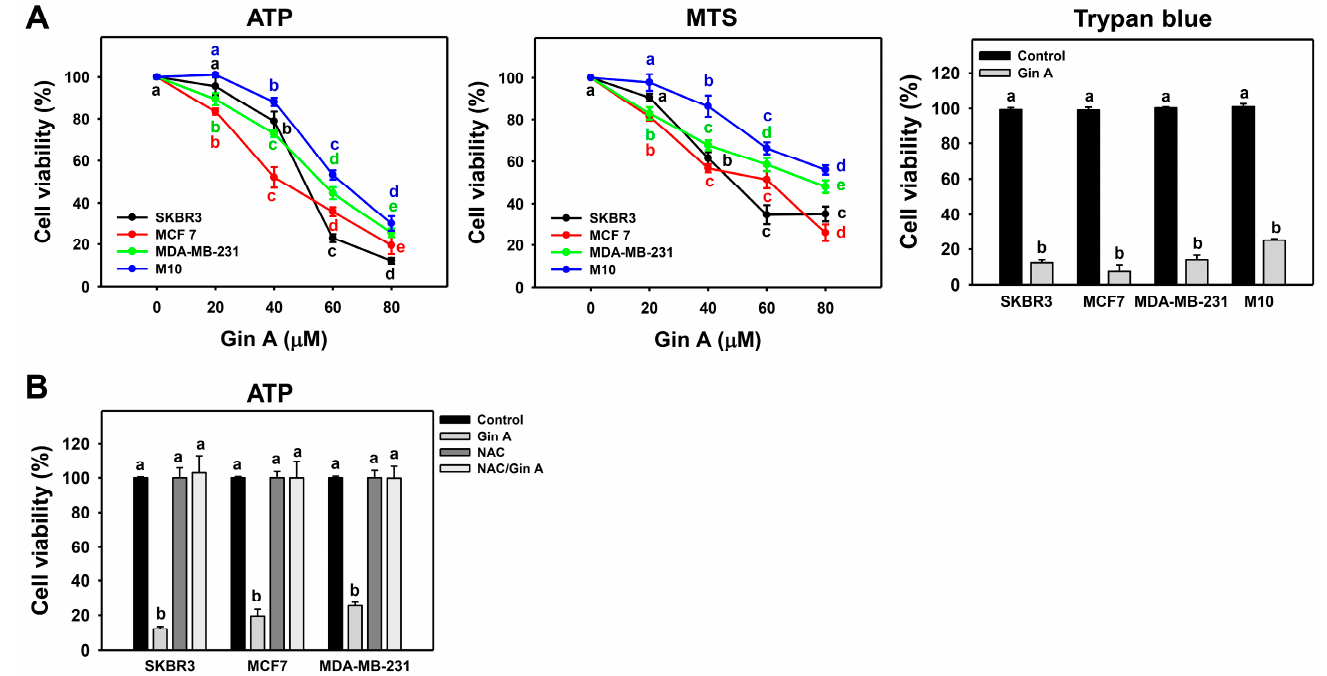
Figure 1. Impact of Gin A on cell viability of breast cancer cells. ( A ) Cell viability. Cells were treated with 0 (0.1% DMSO; control), 20, 40, 60, and 80 µ M Gin A for 48 h. Subsequently, they were subjected to ATP, MTS, and trypan blue (80 µ M) assays to determine cell viability. ( B ) NAC reverted effects on antiproliferation. Cells were pretreated with NAC (10 mM) for 1 h and then post-treated with Gin A (control and 80 μ M) for 48 h, namely NAC/Gin A. Data, means ± SDs ( n = 3). When the connecting letters are overlapping, it means their difference was significant for multiple comparisons ( p < 0.05 to 0.0001). For example, control, NAC, and NAC/Gin A showing a differ non-significantly. These three treatments marked with a differ significantly from Gin A marked with b